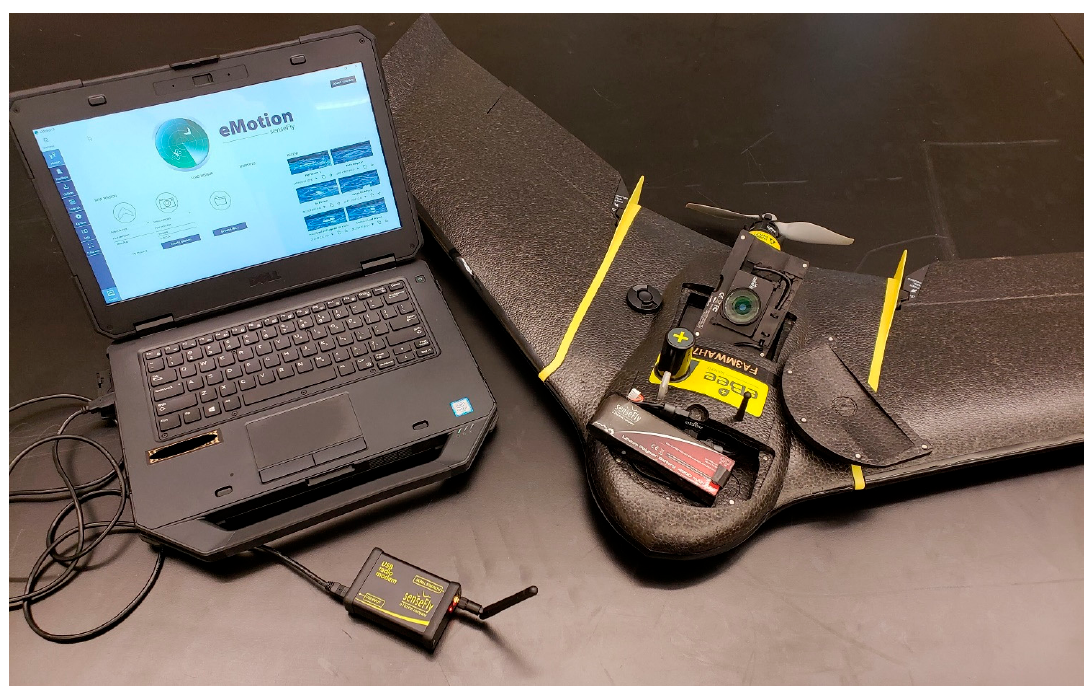
Figure 4. eBee Plus Unmanned Aerial System (UAS) with the sensor optimized for drone applications (S.O.D.A) and eMotion3 flight planning software.